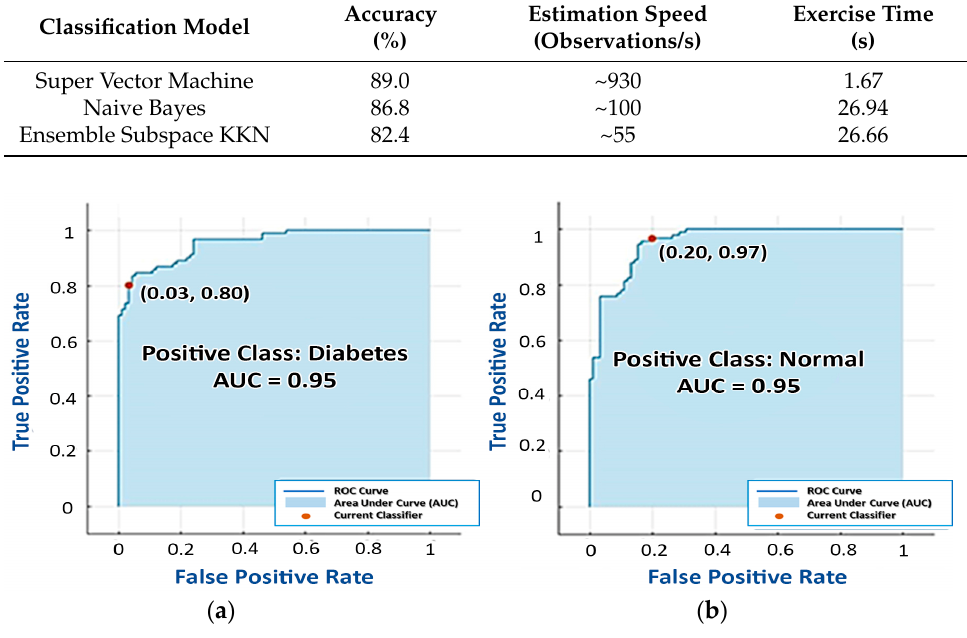
Figure 14. ( a ) Positive-class diabetes ROC curve; ( b ) positive-class normal ROC curve. Table 5. Classification performance of super vector machine classifier.